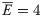
Arrangement of equilibria in (4).The model parameters were set as follows: w = 1.5, p = 0.1, E¯=4, E_=2, ε = 0.05, r = 10, with z taking values in the set {10, 12.2, 25, 50} (these values are denoted as z1, z2, z3 and z4).